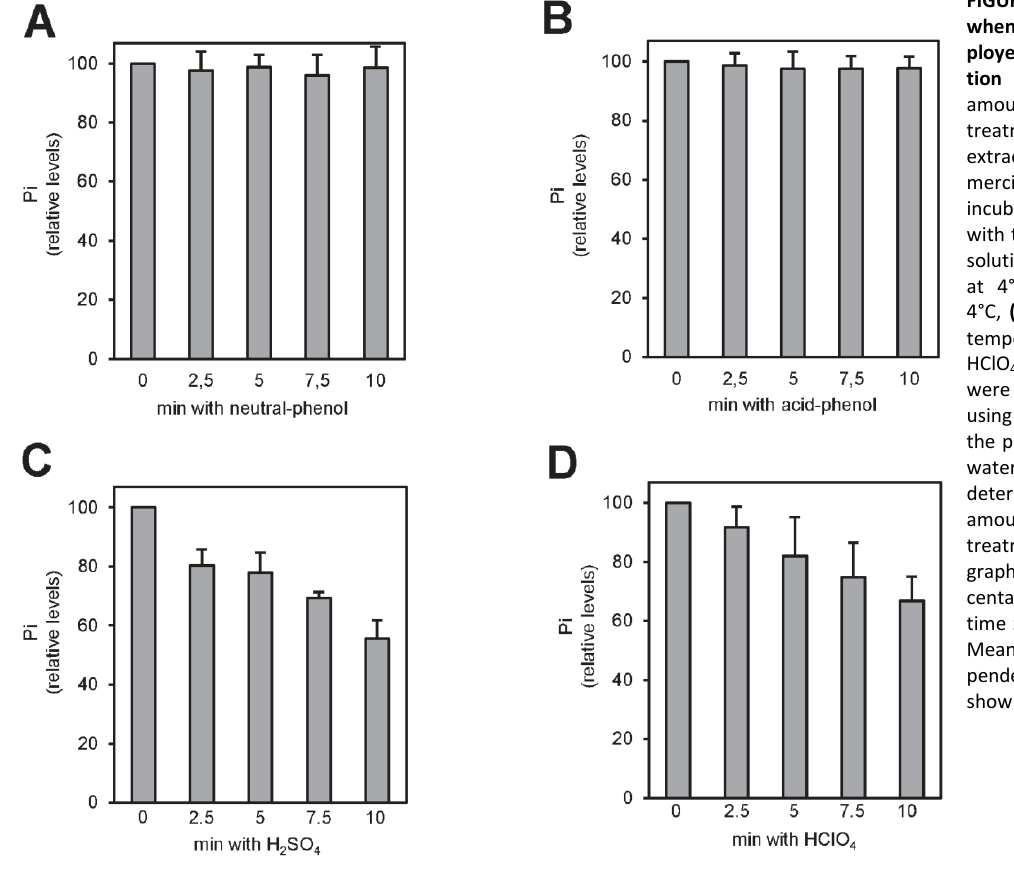
(Figure 2A), the same solution at pH 4.8 (Figure 2B), 1 M sulfuric acid (Figure 2C) or 1 M perchloric acid (Figure 2D).